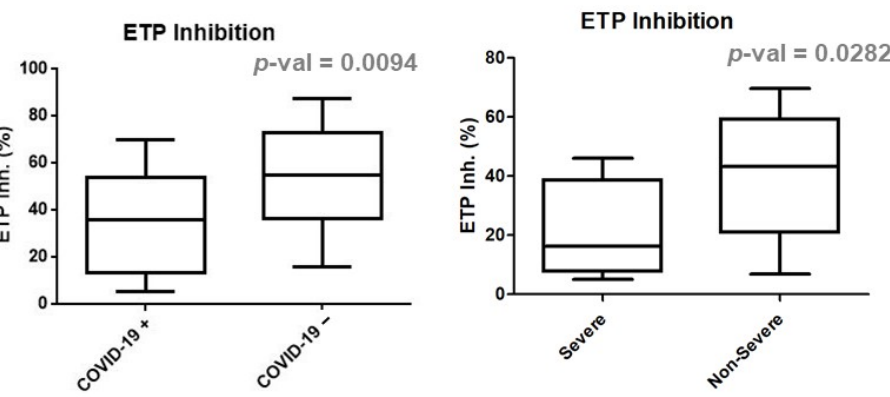
Figure 2. Comparison of inhibition of ETP (%) in COVID-19-negative and COVID-19-positive patients as well as COVID-19-positive “severe” and “non-severe” subgroups.